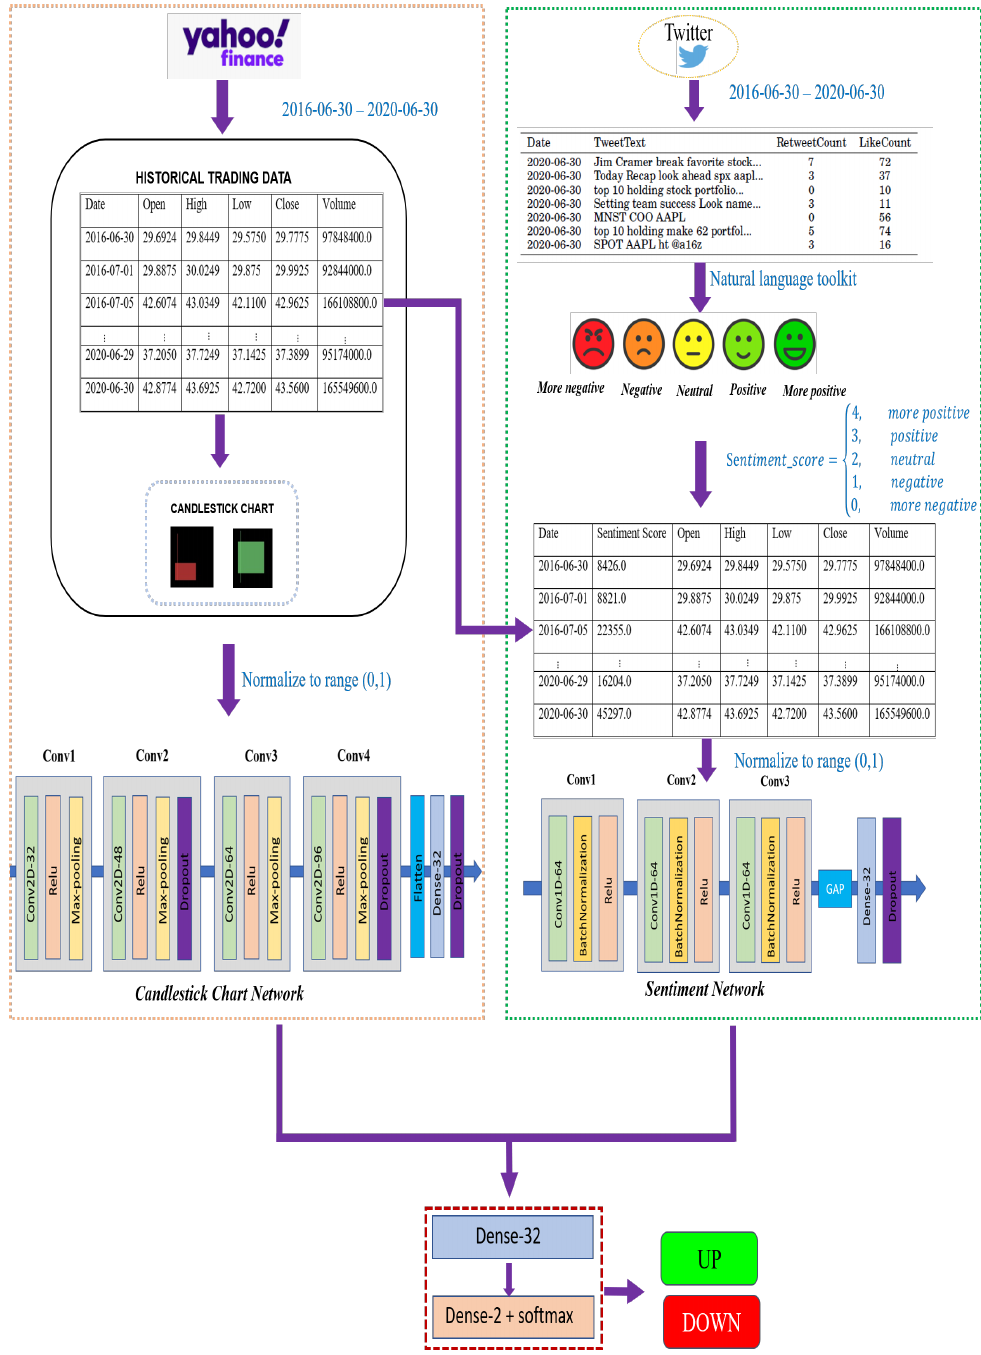
Figure 1. Architecture of the multibranch network for stock trend